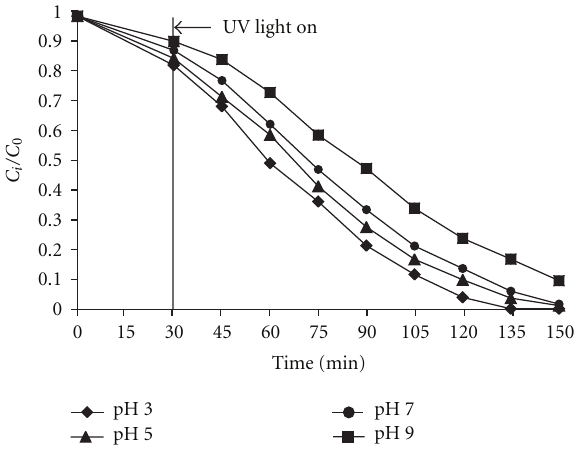
Figure 8: E ff ect of medium pH on the photocatalytic degradation of aqueous phenol solution. Conditions: catalyst comprised TiO 2 nanotubes, silica gel, and colloidal silica in the ratio of 3:2 :20, air flow rate = 0.3L/min and initial phenol concentration = 30mg/L.